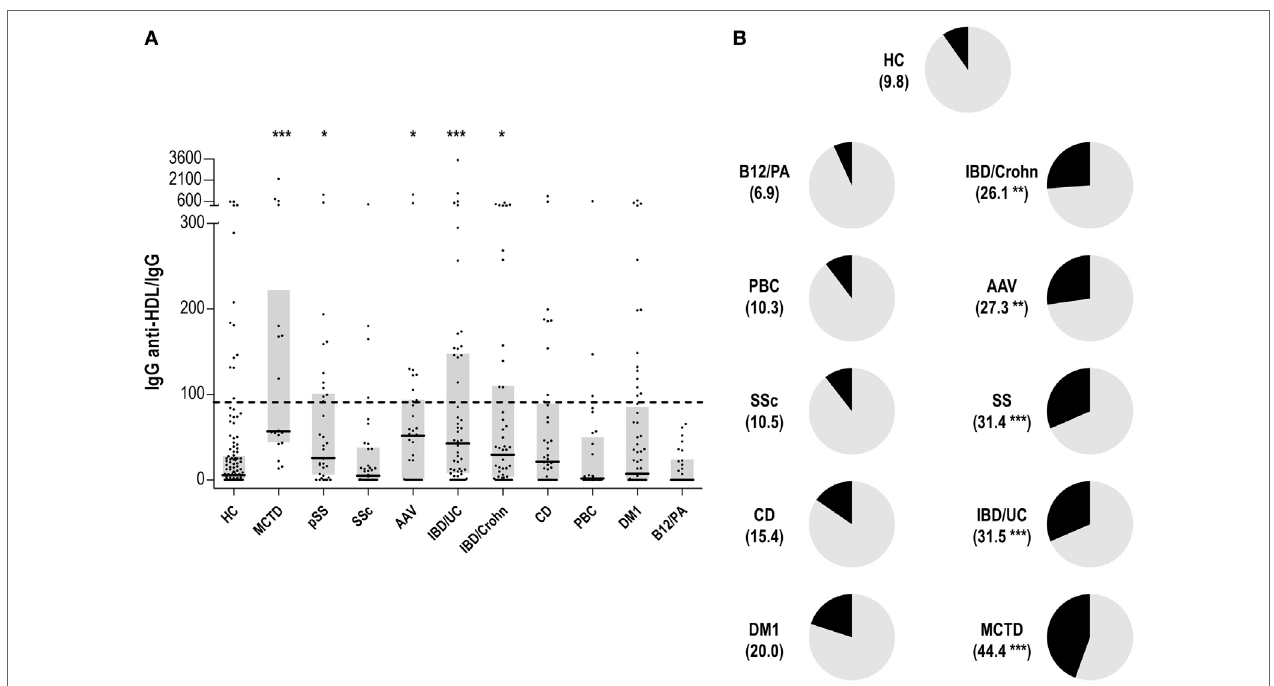
FigUre 1 | Immunoglobulin G (IgG) anti-high-density lipoprotein (HDL) antibodies in different autoimmune conditions. (a) Serum levels of anti-HDL/IgG antibodies in different autoimmune conditions and healthy control (HC). Each dot represents one subject, whereas horizontal bars represent the median value and gray boxes delimit 25th and 75th percentiles. Horizonal dashed lines represents the value of 90th percentile of anti-HDL/IgG in the HC group ( = 90.78). Differences against HC group were assessed by Kruskal–Wallis test and Dunnett correction for multiple comparisons test. (b) Positivity of anti-HDL antibodies in autoimmune conditions. The frequency of individuals classified as anti-HDL positive (using the 90th percentile found in the HC group as reference) is shown for each condition between parenthesis and represented as the black section of each graph. Differences compared to the HC were assessed by χ 2 tests. Statistical significance is indicated as * p < 0.05, ** p < 0.010, and *** p <